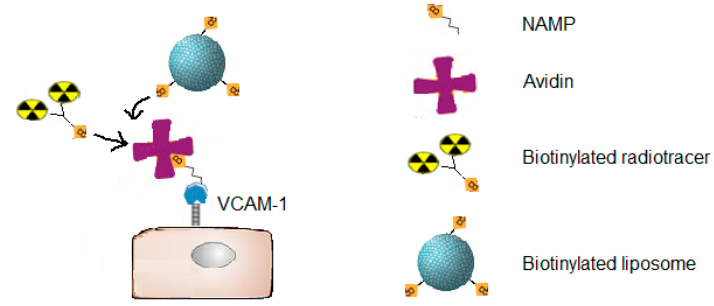
Figure 24. NAMP structure.